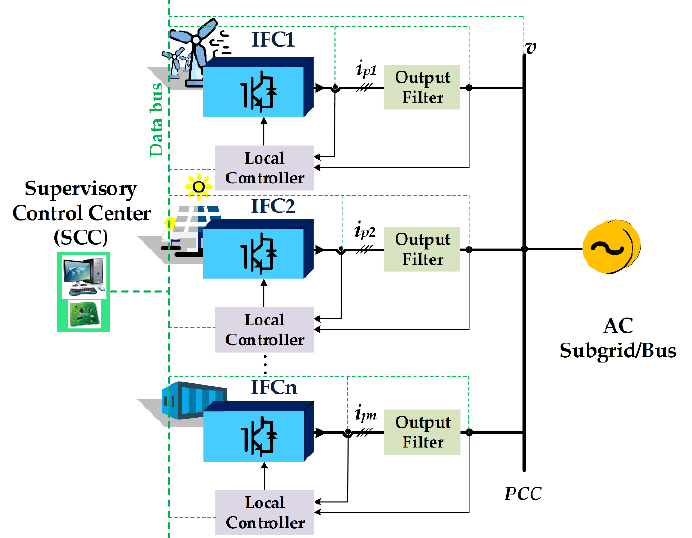
Figure 2. Centralized structure of supervisory control in power electronics-intensive smart microgrids.